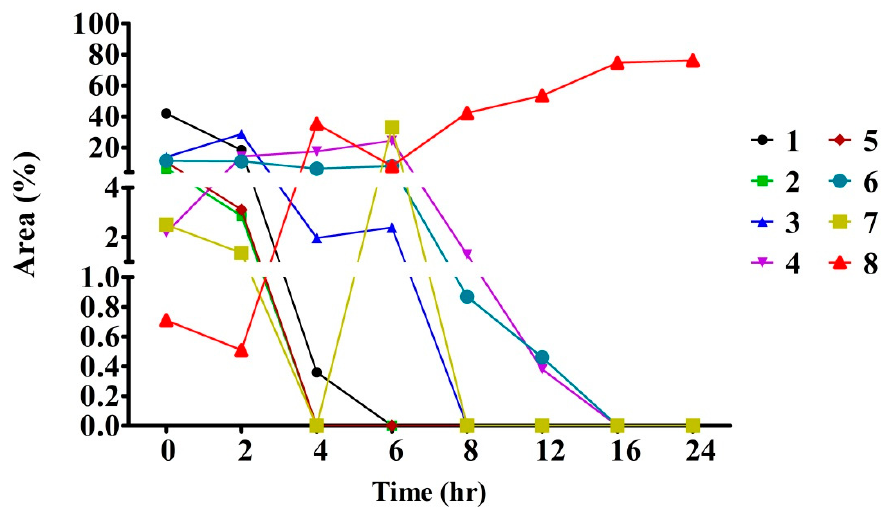
Figure 4. Enzymatic transformation of trans -crocetin during a 24 h incubation of crocins extracts from gardenia fruit waste using Celluclast ® 1.5 L enzymes. Crocins extracts (2 mM) were reacted with 1.0 mL of Celluclast ® 1.5 L enzymes in 10 mL of 100 mM citrate buffer (pH 5.0) at 50 °C. Data presented the averages of 2 experiments as determined by HPLC analysis detected at 440 nm. A